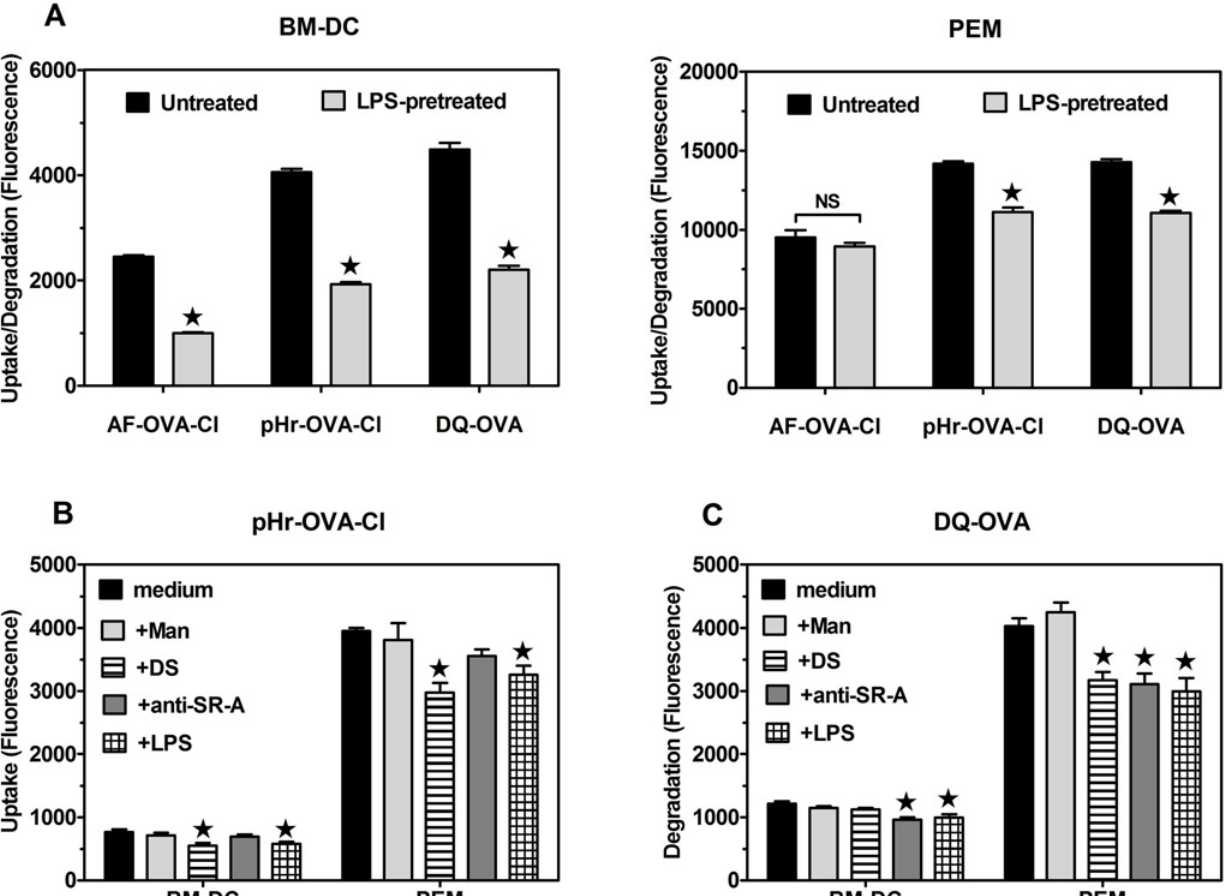
Fig 11. LPS and SR-A ligands regulate uptake, acidification and proteolysis of endocytosed antigens. ( A ) Effects of 1-day pre-treatment with 100 ng/ ml LPS on the total uptake of AF-OVA-Cl, internalisation of pHr-OVA-Cl and degradation of DQ-OVA by BM-DC and PEM. ( B , C ) Effects on indicated ligands on the acidification of pHr-OVA-Cl-containing endosomes (B) and proteolytic digestion of DQ-OVA (C) in BM-DC and PEM. The results shown are averages +SEM from 3 independent experiments, each performed in 4 replicates. The data were analysed by the Student ’ s t-test (A) or by ANOVA, with the Dunnett ’ s post-test applied to compare the control ( “ medium ” ) with other groups (B, C). * , p <